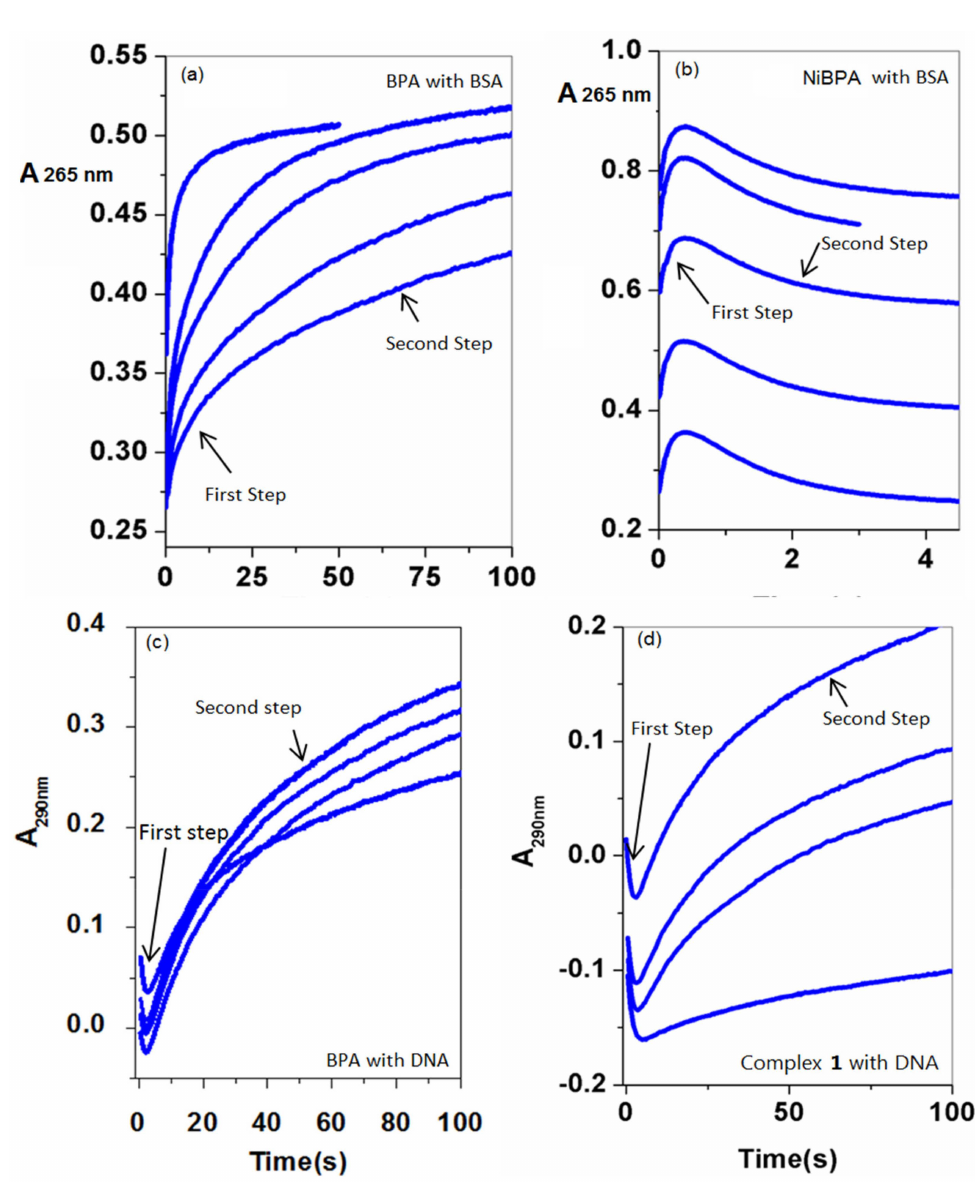
Figure 7. Kinetic traces of different concentrations of ( a ) BPA with BSA, ( b ) NiBPA with BSA, ( c ) BPA with ct-DNA and ( d ) NiBPA with